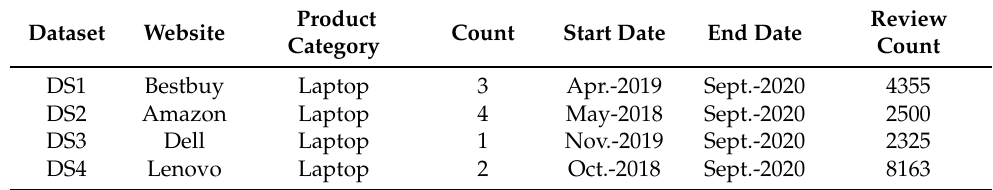
Table 2. Characteristics of the collected